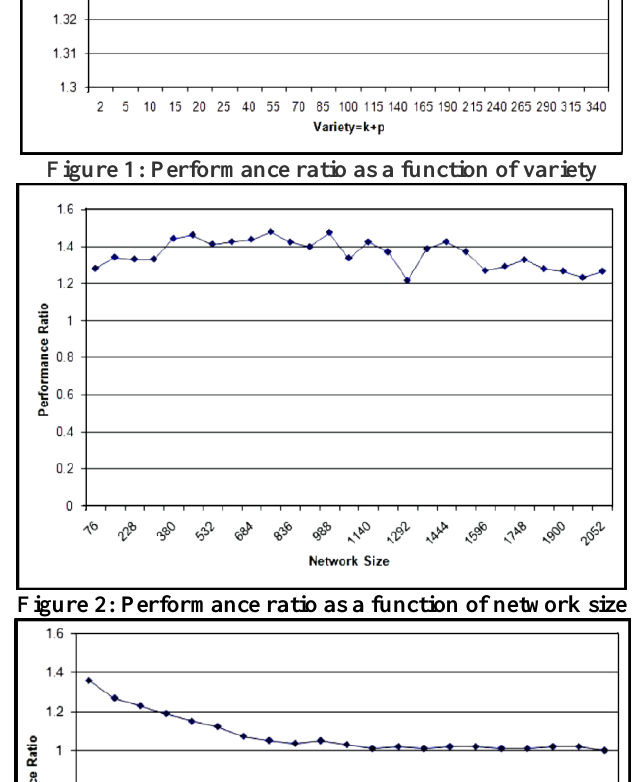
Figure 2: Performance ratio as a function of network size